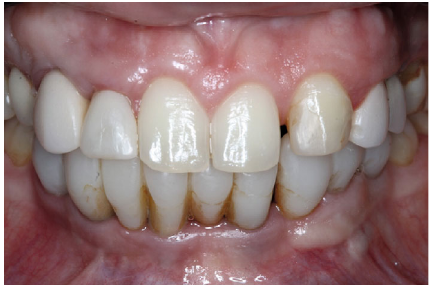
Figure 10: Buccal view of the four-year